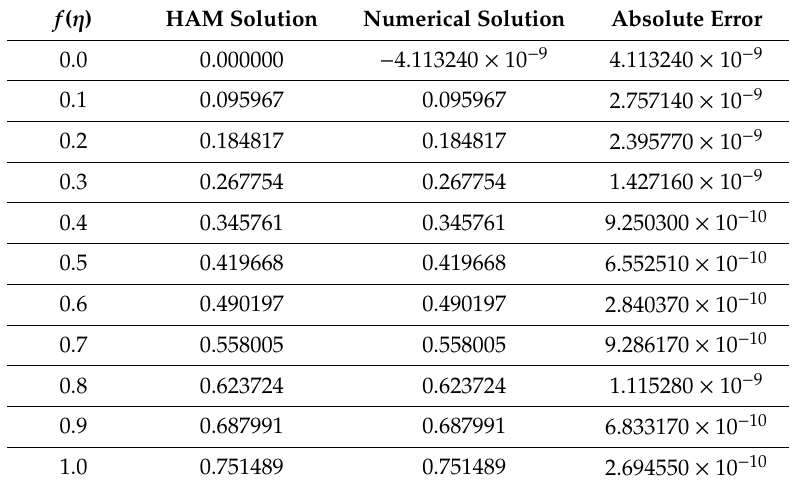
Table 1. Comparisons of the homotopy asymptotic method (HAM) and numerical solution.